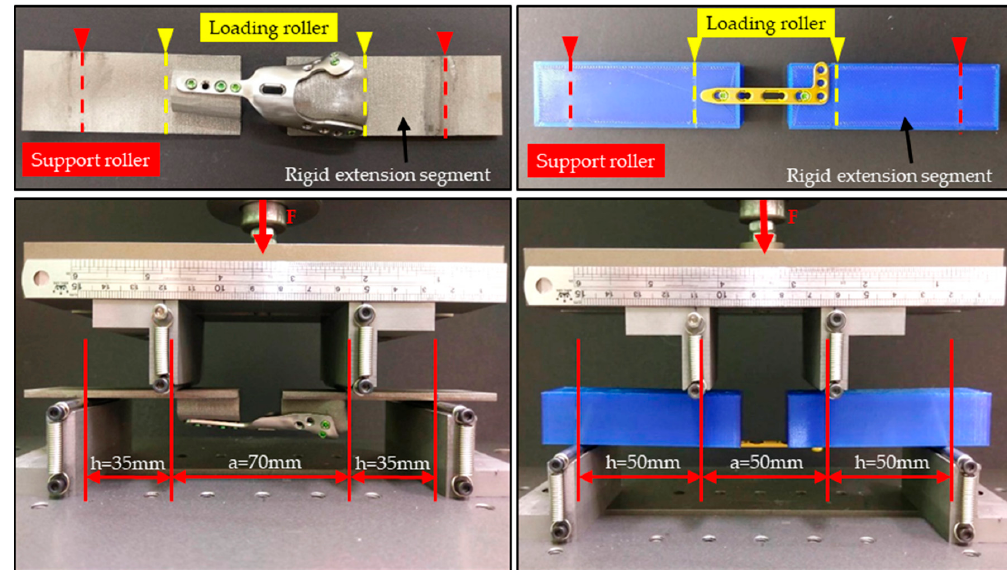
Figure 2. The HDDP (left part) and L-plate (right part) were fixed onto the corresponding rigid extension segments; the loading rollers made contact with the rigid extension segments of the test setup during the test.